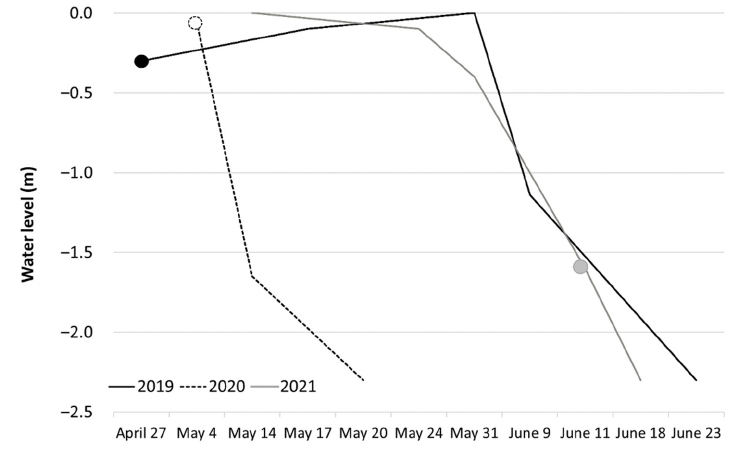
Figure 3. Trend of the hydrometric levels of the Palazzo Borghese pond, in the three years of monitoring. Black, dotted, and grey circles represent the appearance of C. sibyllae active stages for the years 2019, 2020, and 2021, respectively.